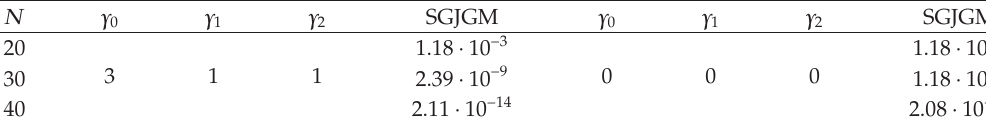
Table 4: Maximum pointwise error of u − u